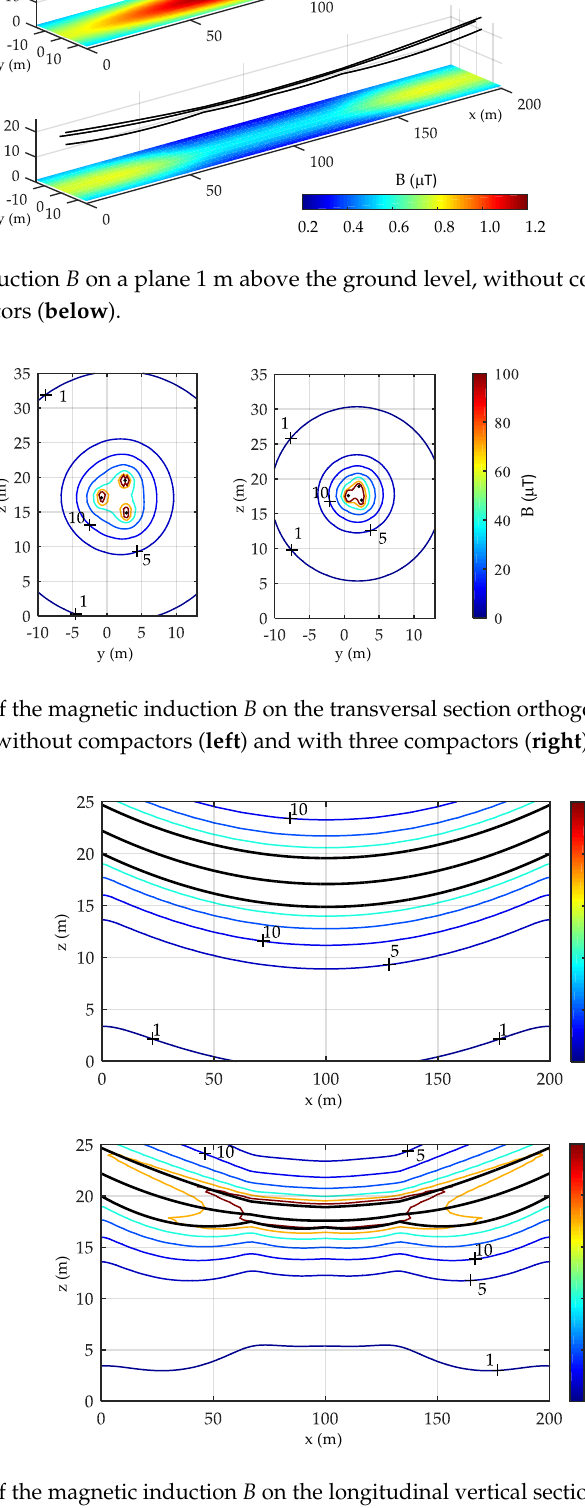
Figure 7. Distribution of the magnetic induction B on the longitudinal vertical section passing through the central compactor barycenter. ( a ) Without compactors; ( b ) With three compactors.